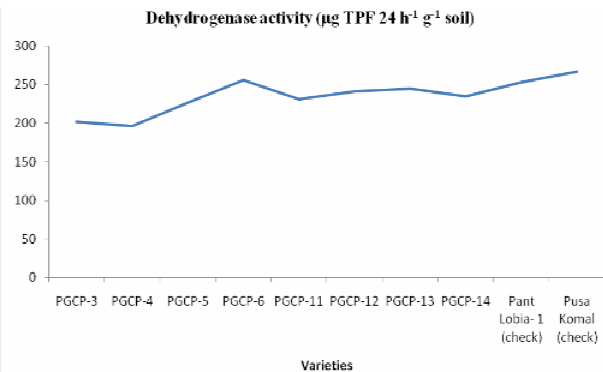
Fig. 3. Dehydrogenase activity (µg TPF 24 h -1 g -1 soil) in soil as influenced by cultivar